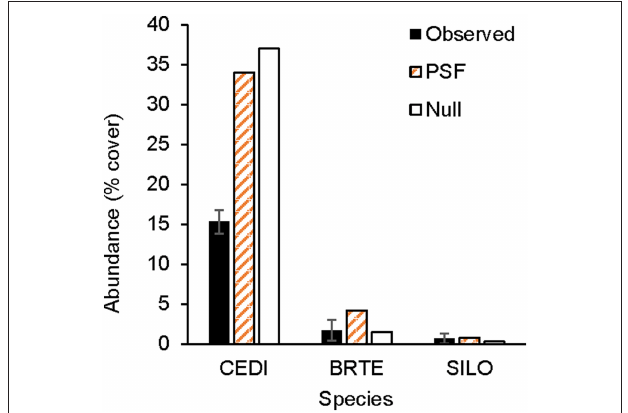
FIGURE 5 | Observed and predicted abundance of non-native plant species in a three-species experimental plant community grown for 3 years (2011–2013). Model predictions were made either with plant-soil feedback effects (PSF) or without plant-soil feedback effects (Null). Species codes listed in the Figure 4 .